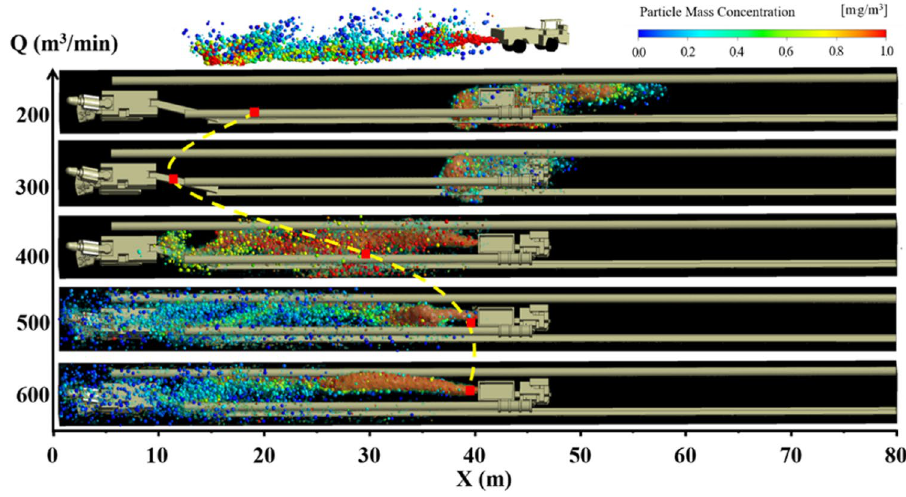
Figure 12. DPM distribution under different air volumes Q at L = 60